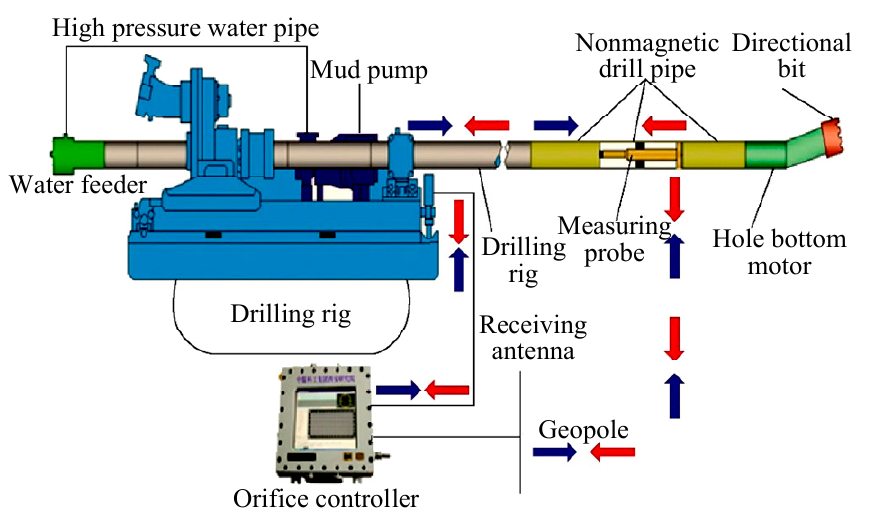
Figure 9. Wireless MWD system of electromagnetic wave for mining. Figure 8. Overall structure design diagram of mine electromagnetic wave wireless measurement while drilling system.